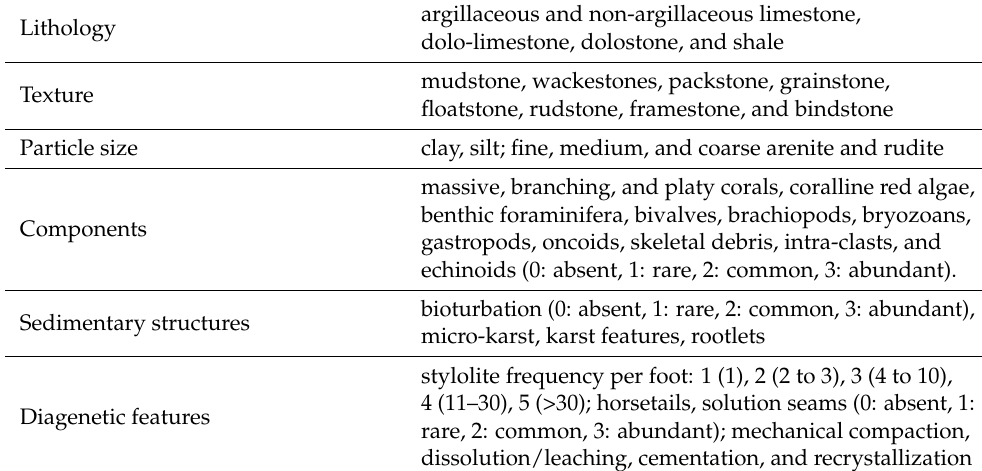
Table 2. Attributes for sedimentological